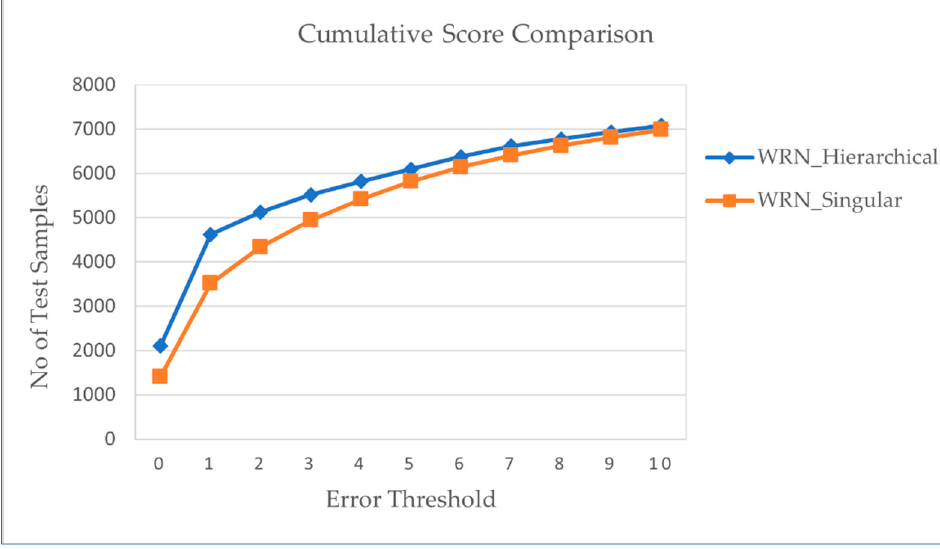
Figure 10. Cumulative score comparison among singular versus hierarchical approach designed for the real age estimation task using the WideResNet (WRN) model.